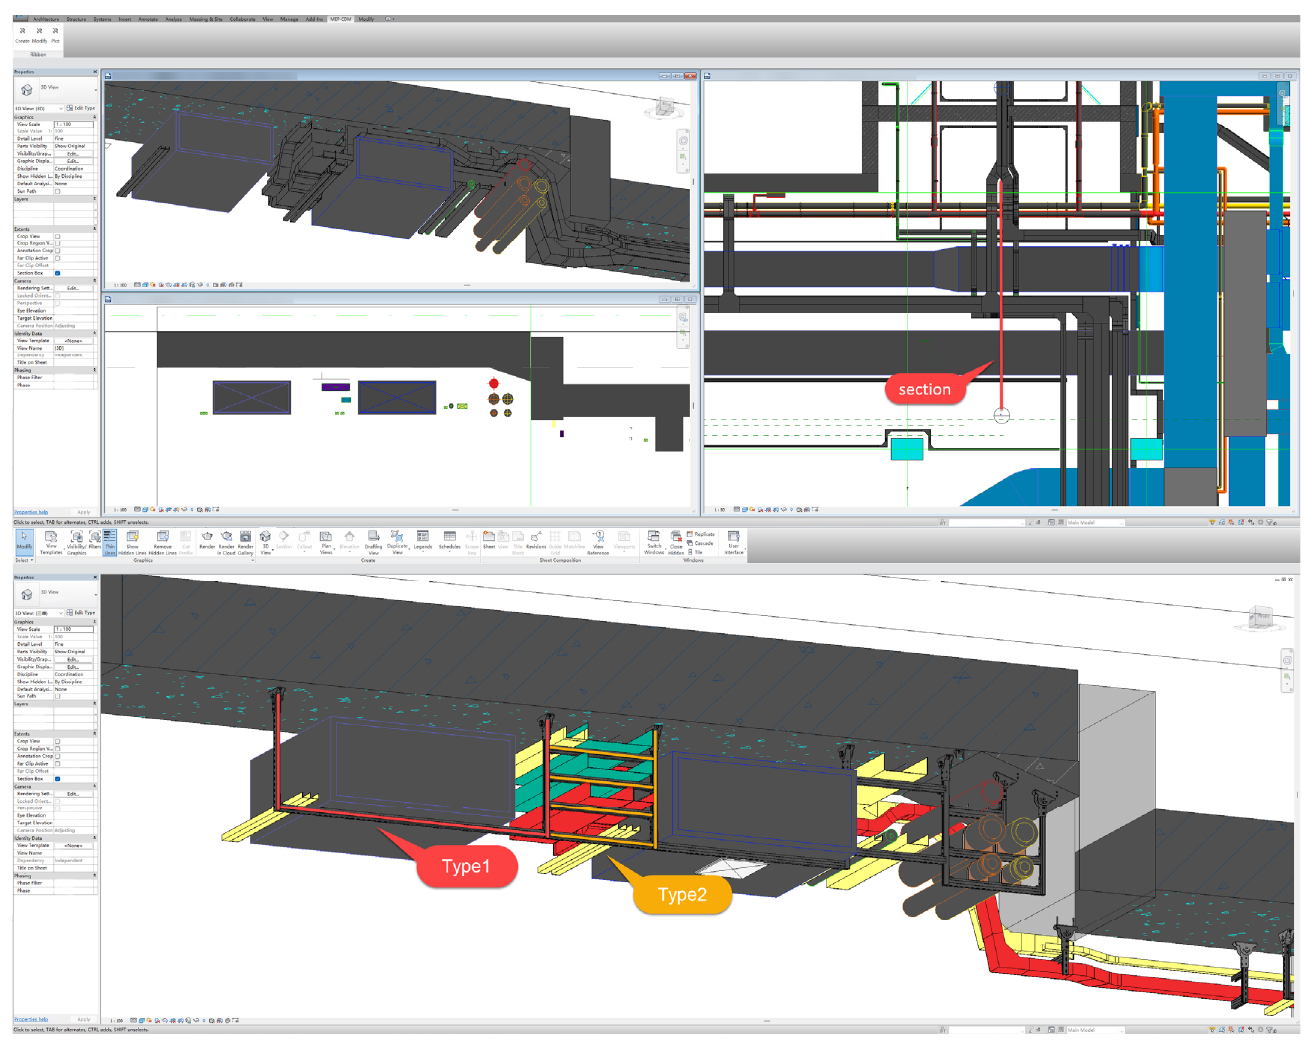
Figure 13. Usage of the quick placement system.